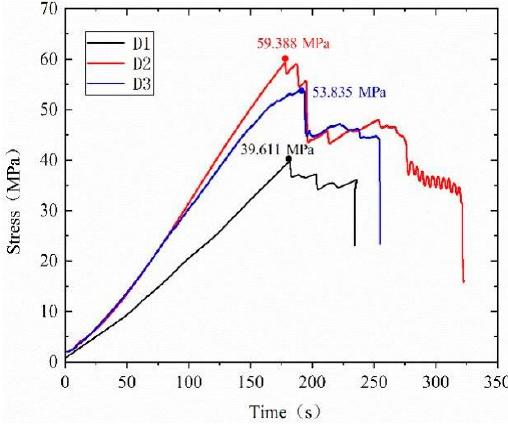
Figure 5. Uniaxial compressive strength of continental shale.